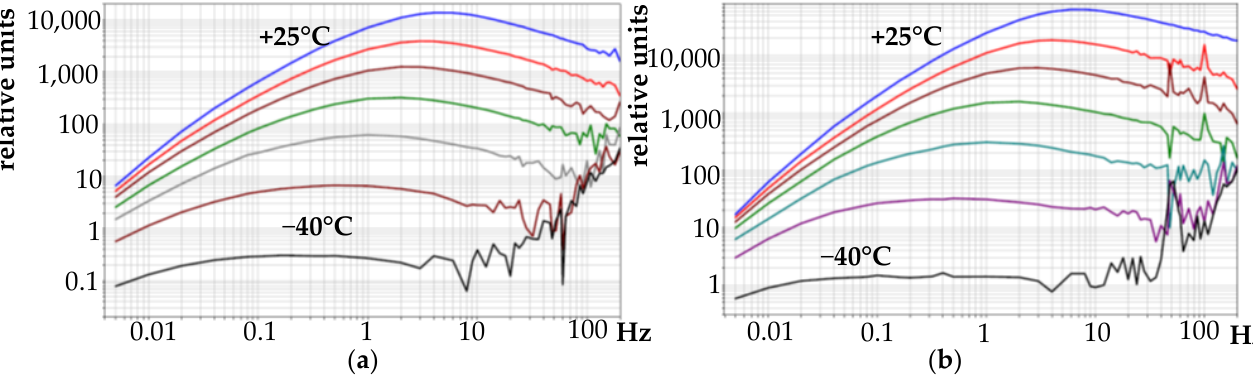
Figure 5. Families of amplitude-frequency characteristics of the studied samples depending on the